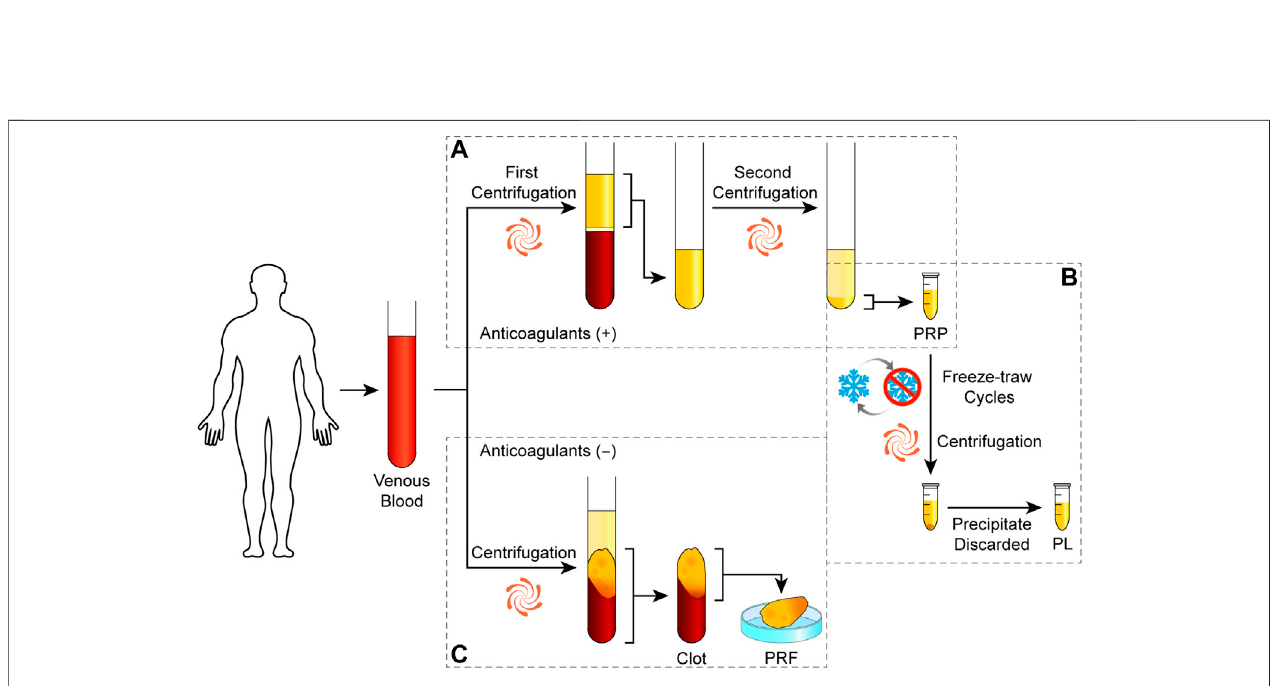
SCHEME 2 | Preparation protocols of platelet derivatives. Schematic drawing of the classical preparation protocols of PRP (A) , PL (B) , and PRF (C) .